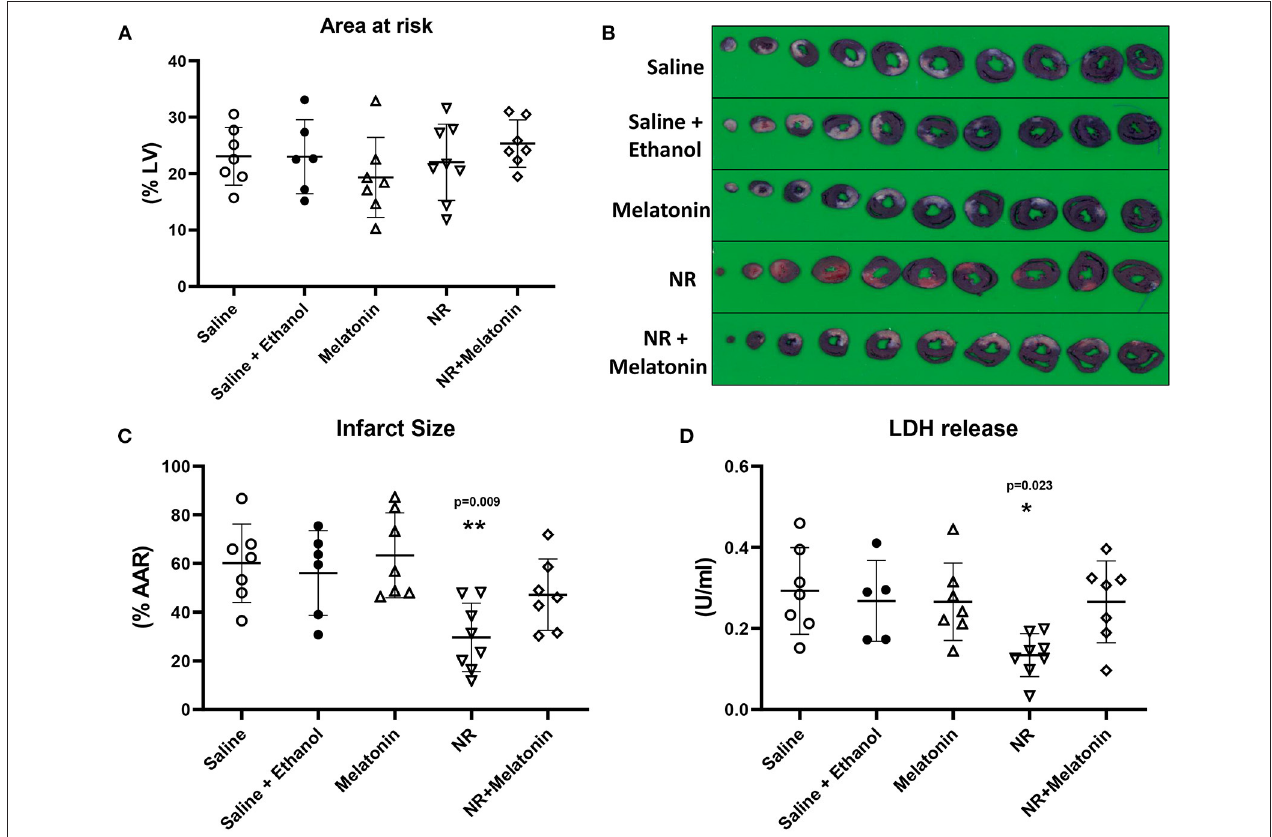
FIGURE 3 | NR treatment alone showed maximal protection against in vivo cardiac IR injury. NR (50 mg/kg) treatment ( n = 8) alone before ischemic insult reduced infarction, but not melatonin (500 µ g/kg; n = 7) or NR + melatonin ( n = 7). (A) Area at risk (AAR) related to left ventricle area (LV); (B) Image of TTC staining; (C) Infarct